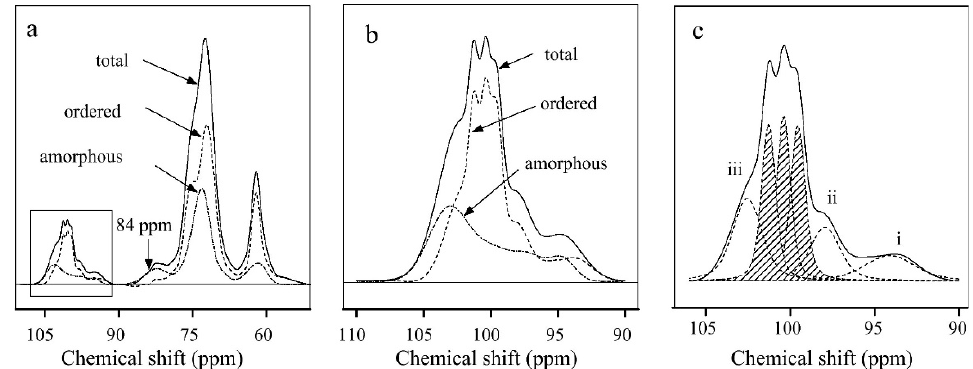
Figure 2. 13 C CP MAS NMR spectrum of recrystallized cassava starch: ( a ) spectrum decomposition into ordered and non-ordered amorphous phases, ( b ) expansion of the C 1 region between 90 and 110 ppm, and ( c ) deconvolution of the ordered phase in indicating three deconvoluted peaks for A- polymorph, two deconvoluted peaks in the case of B-polymorph and the interfacial phases indicated by i, ii and iii. Adapted with permission from Ref. [43]. Copyright 2012, Elsevier.